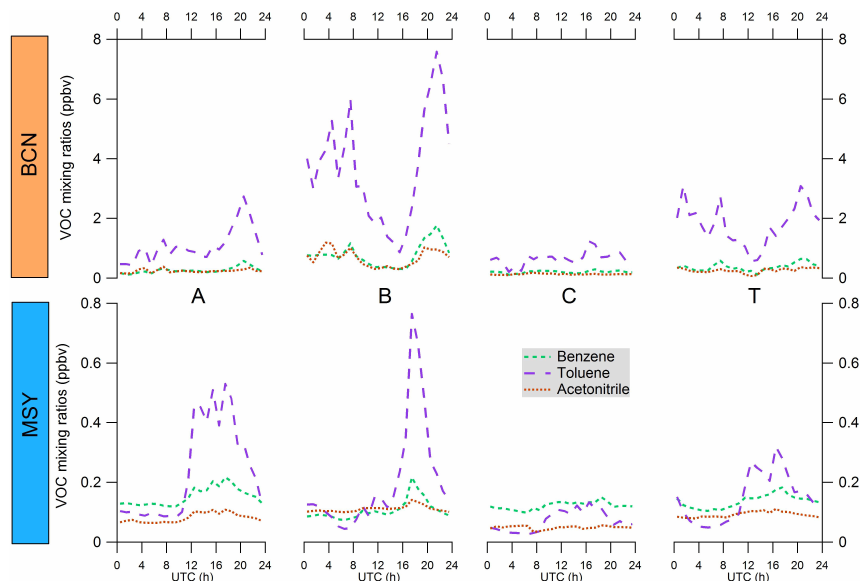
Fig. 8. Average aromatic VOC and acetonitrile mixing ratios for each atmospheric scenario at BCN (top panels) and MSY (bottom panels). Note the different scaling between top and bottom panels (one order of magnitude). Table 3. Minimum and maximum hourly averaged VOC mixing ratios (ppbv) recorded at the BCN station during each of the atmospheric scenarios (A, B, C, T) described in Sect. 2.4. These values correspond to the data displayed in Figs. 6–8. A B C T Hourly averages Hourly averages Hourly averages Hourly averages BCN Minimum Maximum Minimum Maximum Minimum Maximum Minimum